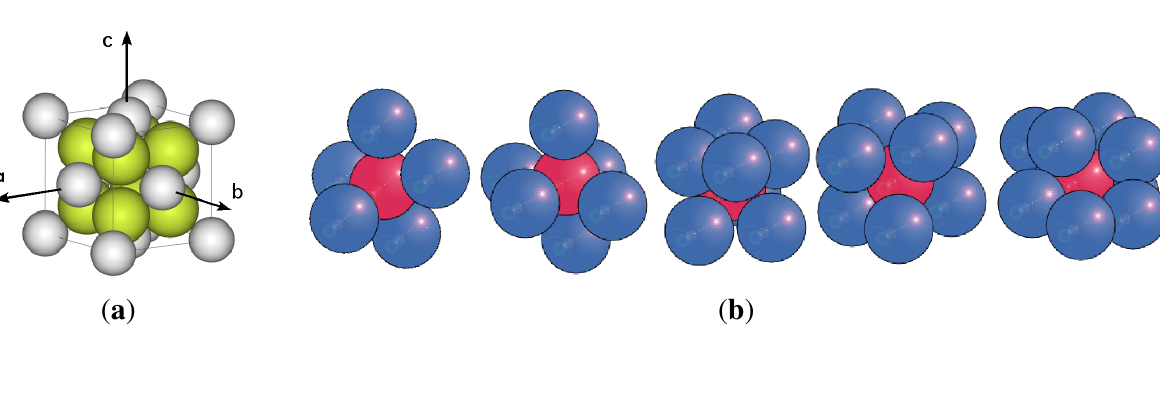
Figure 1. On left, an ordered crystalline motif of touching spheres. On right, random clusters with different number spheres touching the inner